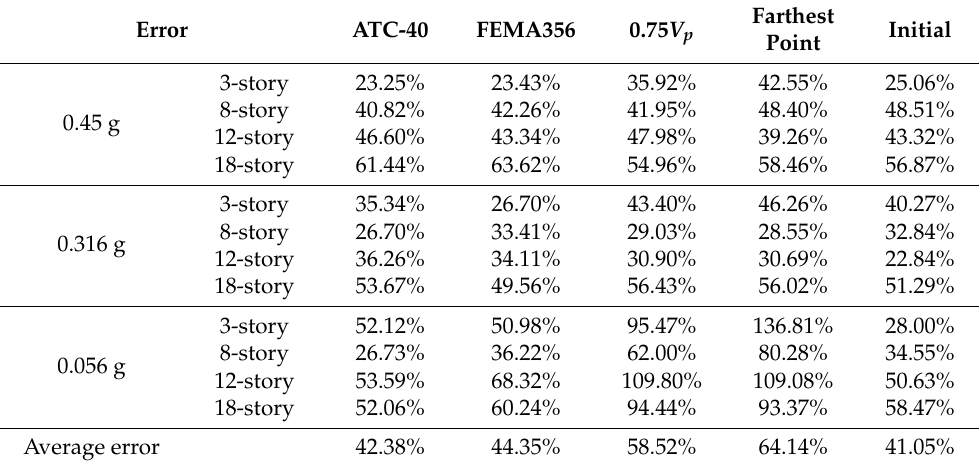
Table 3. Errors of calculated inter-story drift ratios (average value of all the